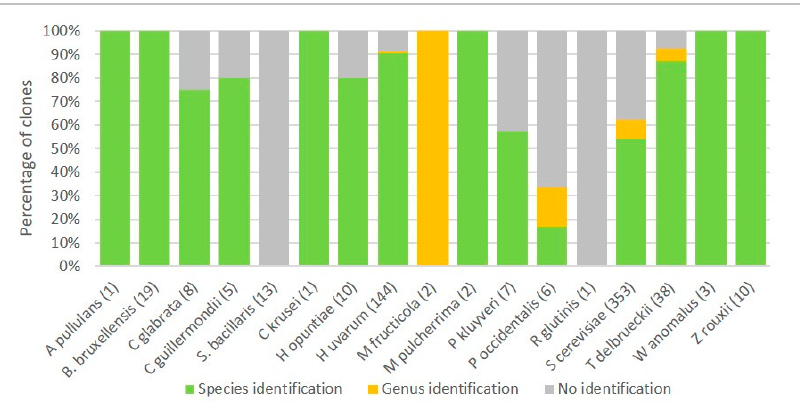
Figure 1. Percentage of clones given identical identification by 26S rDNA sequencing and MALDI- TOF MS (the number of clones considered is given in